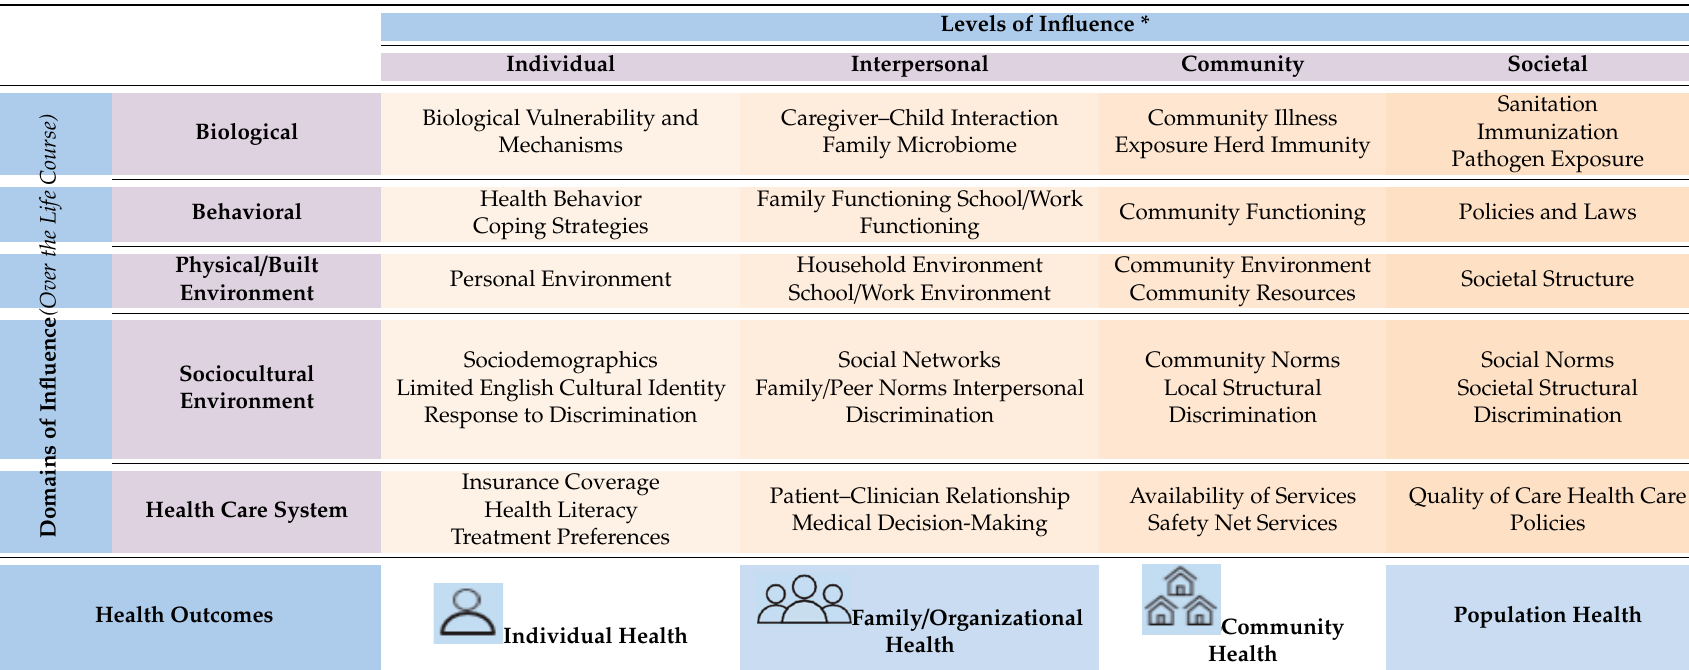
Table 1. National Institute on Minority Health and Health Disparities’ Health and Health Disparities Research Framework.